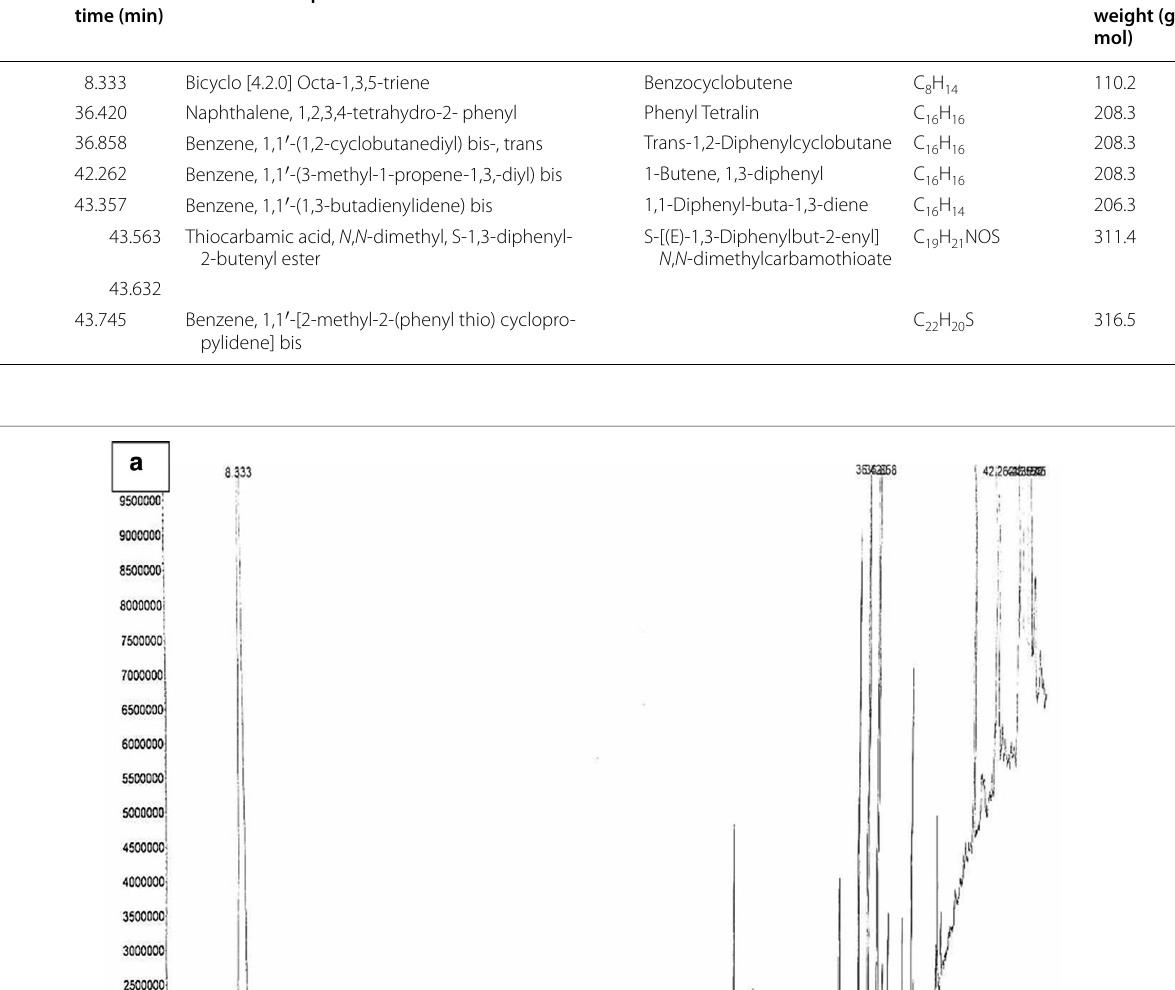
Table 1 GCMS analysis of Tetracarpidium conophorum seed extract Peak no. Retention Identified compounds time (min)